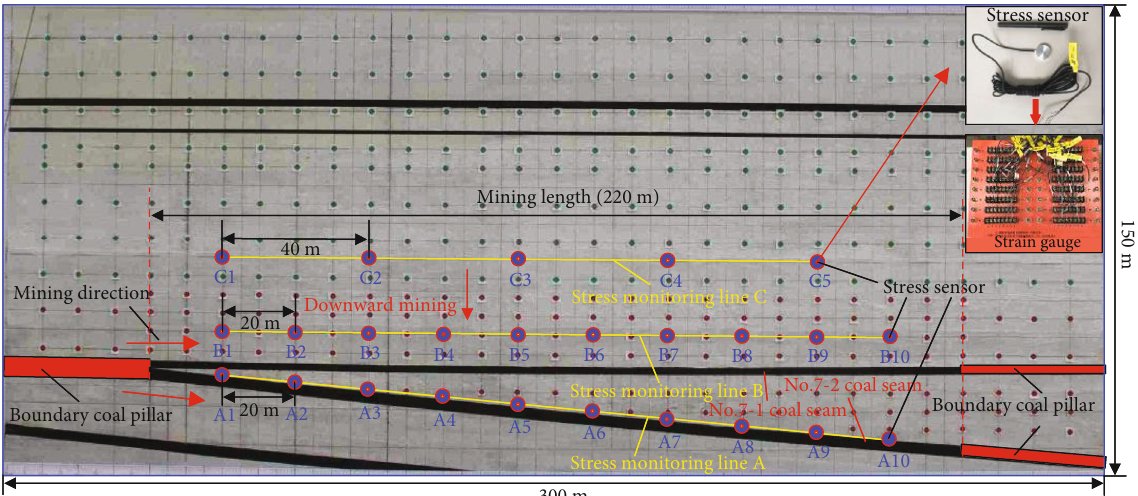
Figure 3: Schematic diagram of the monitoring line layout in the